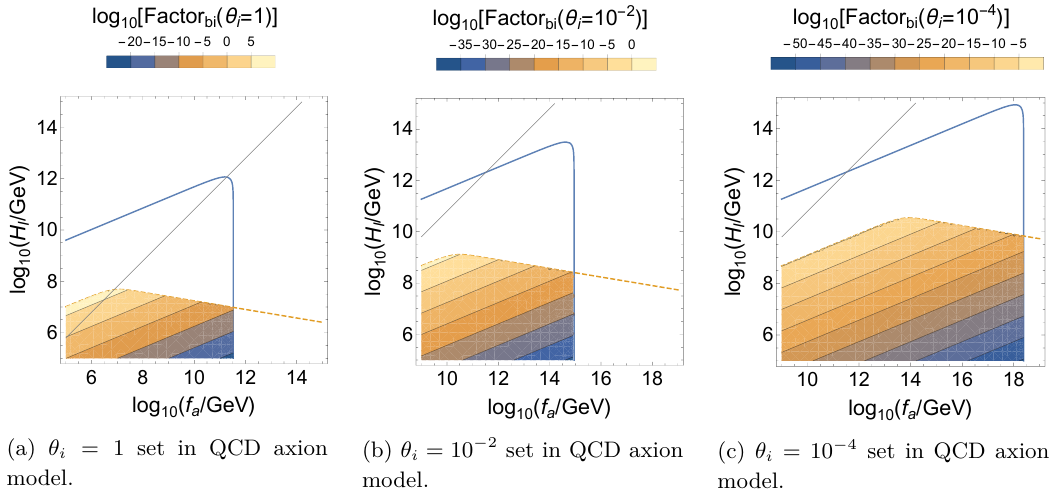
model. model. Figure 7. For QCD axion model in PQ broken scenario, the amplitude of Factor bi ( f a , H I ) defined as (5.9) (to be multiplied to functions displayed in figure 6), is shown in the region constrained by the dark matter abundance and isocurvature spectrum. The solid lines present when axions constitute all dark matter, and dashed lines are from isocurvature constrain, with different initial misalignment angles θ , which are the same as shown in figure 4. We can see that, the factor in i QCD axion case can reach O (1) when θ = 1 , and maximally of O (10 − 5 ) when θ = 10 − 4 . i i